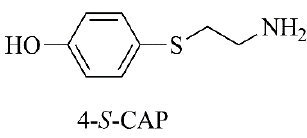
Figure 9. Chemical structure of 4- S -CAP.